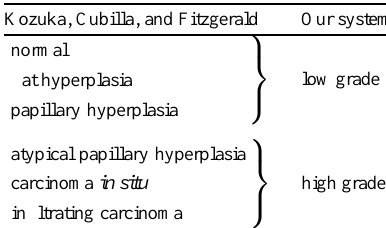
Textural features